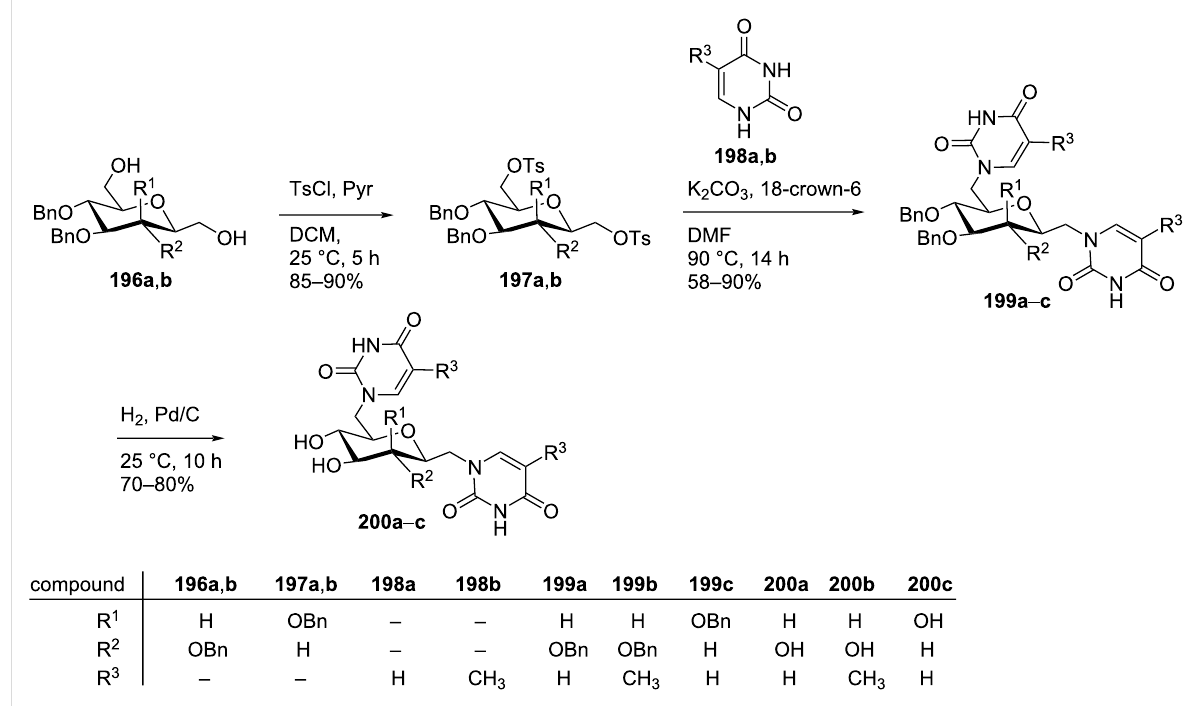
Scheme 52: Synthesis of hexopyranosyl double-headed pyrimidine homonucleosides 200a–c .